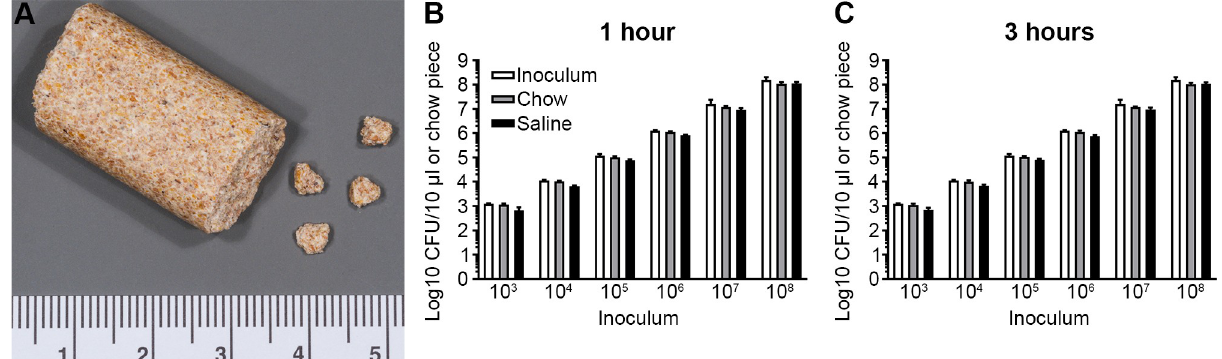
Fig 1. Salmonella survival on mouse chow. (A) Representative image of a regular mouse chow pellet and prepared chow fragments. Ruler scale in centimeters. (B, C) Survival of Salmonella on chow and in SPGS, 1 and 3 h after inoculation. Original inoculum added as a comparison. Data represent the mean ± SD of three independent experiments (n = 1 per